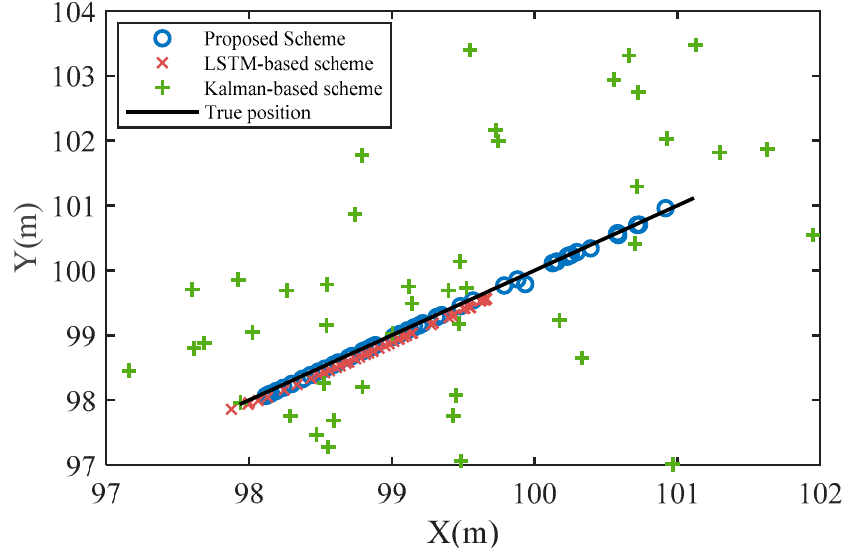
Figure 6. Agent’s movement position.